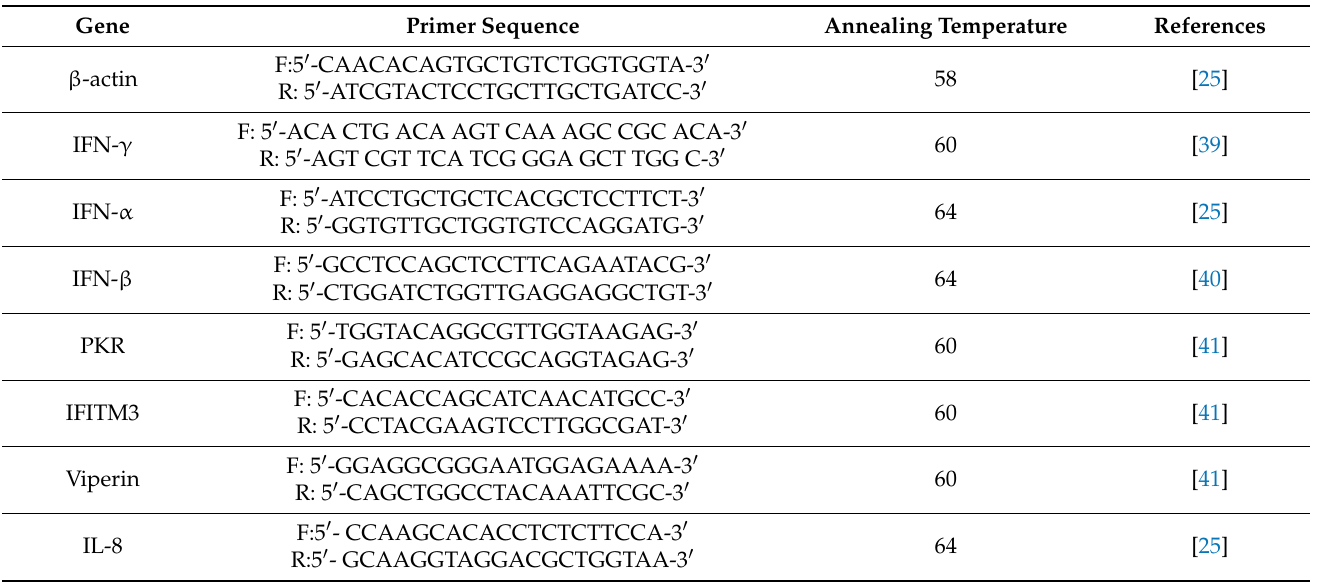
Table 1. Primer sequences used for quantitative real-time polymerase chain reaction. Gene Primer